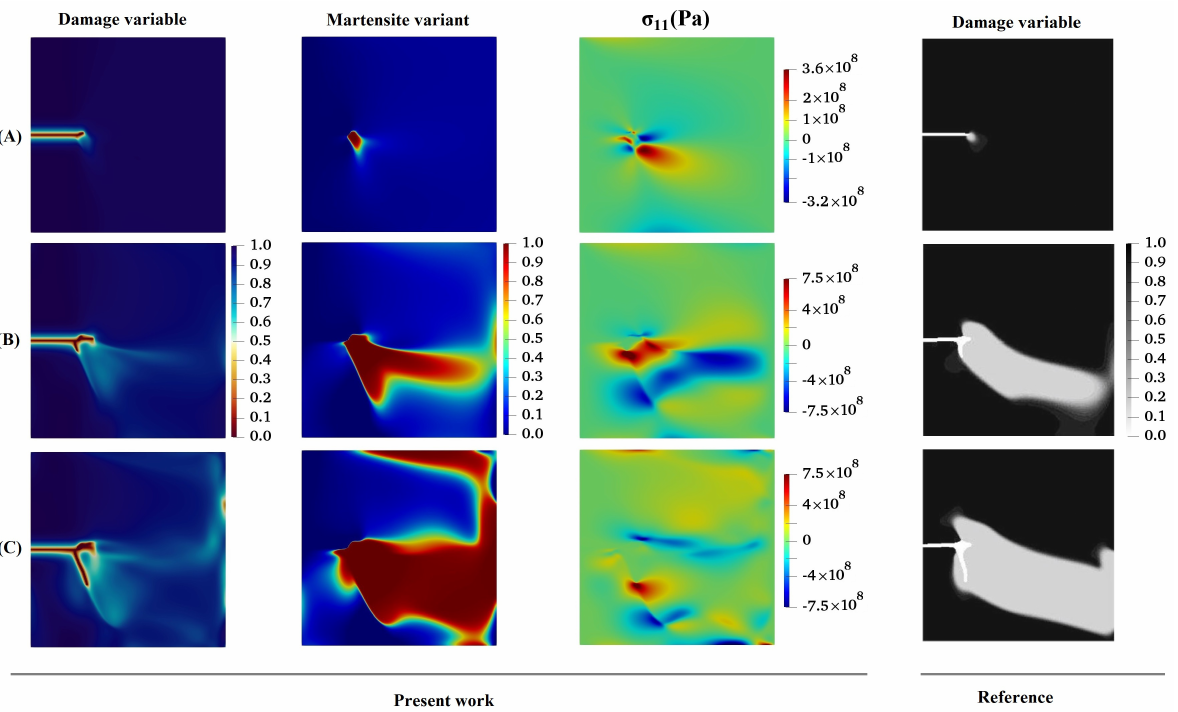
Figure 3. Contour plots of evolution of damage variable, martensite variant, and corresponding σ 11 -component in a coupled problem of one-variant MPT and fracture.